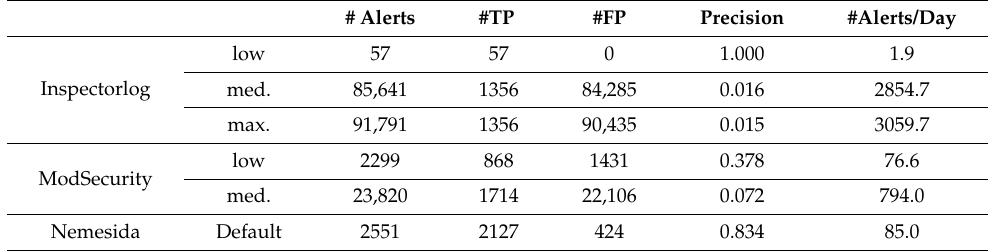
Table 5. Alerts generated, FP, TP and precision with Inves trace.